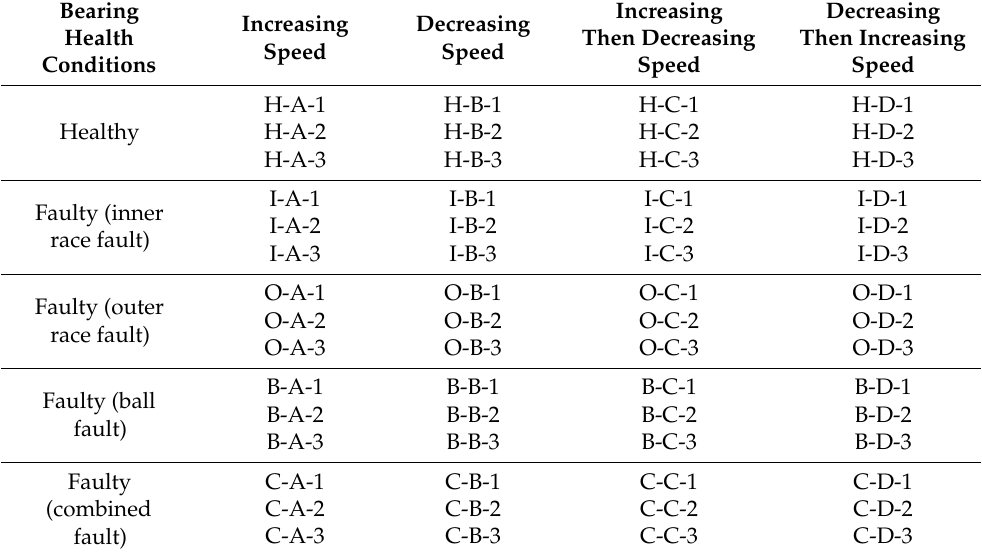
Figure 2. The Experimental platform of the University of Ottawa bearing test rig for a ball bearing system. Table 1. Bearing health or failure and test conditions.